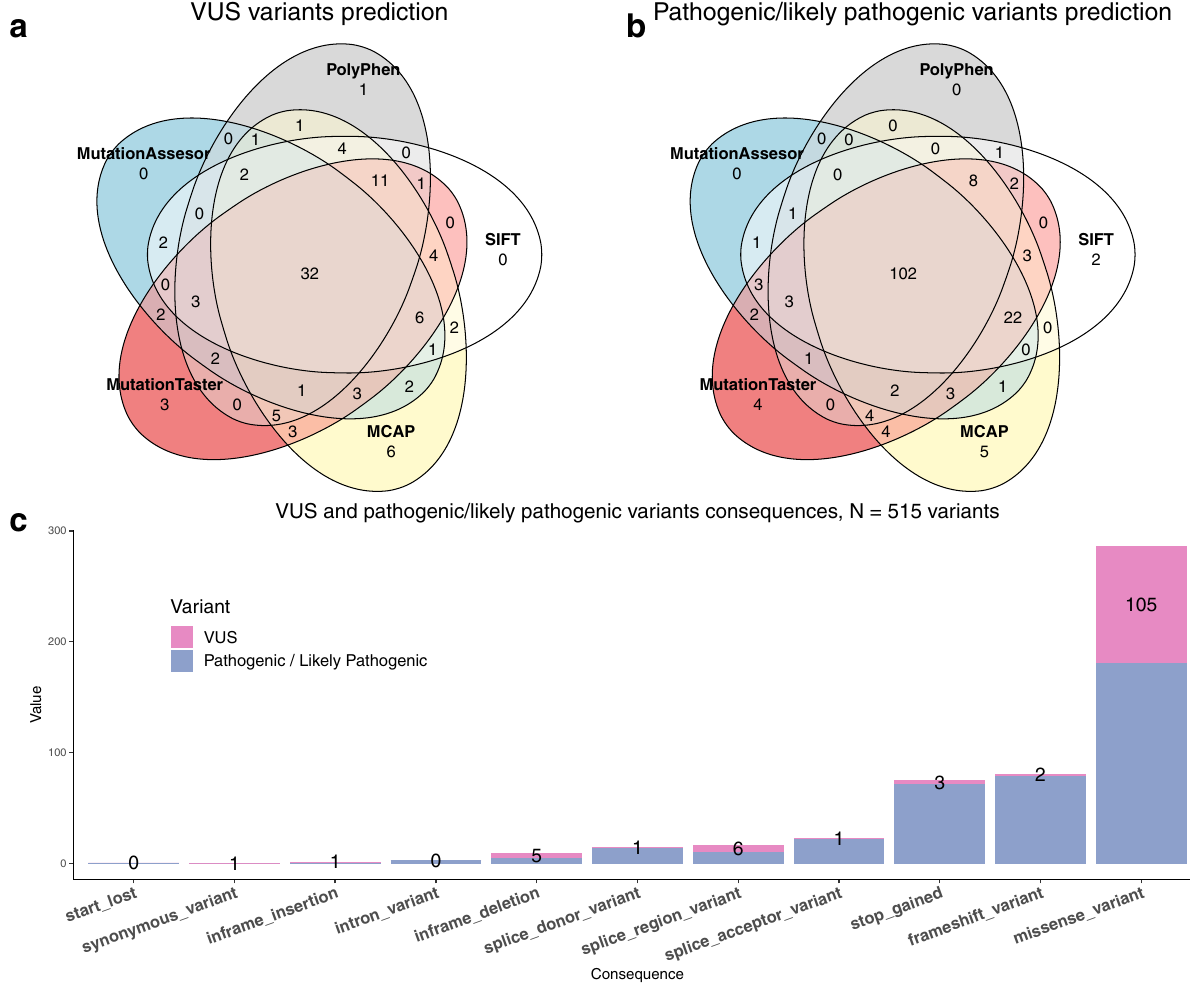
Fig. 4 Pathogenicity and variant consequence. Behavior of pathogenicity predictors for VUS variants ( a ) and pathogenic/likely pathogenic ( b ) variants, and variant consequence distribution for pathogenic and VUS ( c )